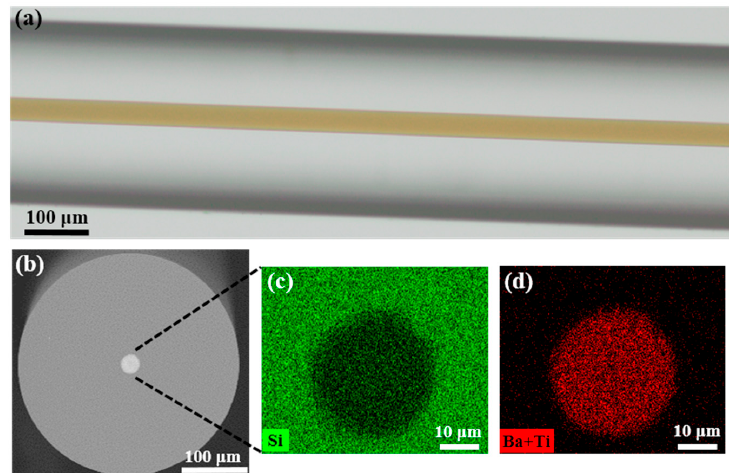
Figure 2. ( a ) The optical transmitted microscopic image of the fabricated BTS glass–ceramic fiber which has a transparent-brown core; ( b ) BSE image of the cross section of the fiber; ( c – e ) EDX mapping of elements Si, Ba, and Ti in the core. (BSE: Back scattered electrons, EDX: Energy-dispersive X-ray